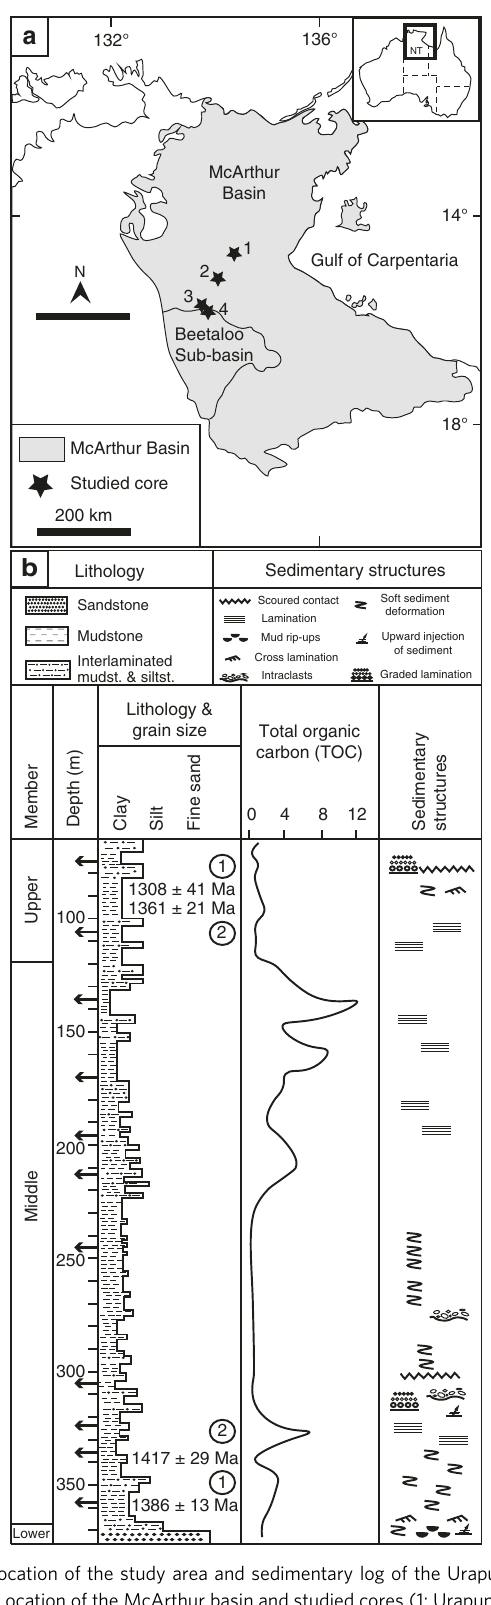
Fig. 1 Location of the study area and sedimentary log of the Urapunga-1 core. a Location of the McArthur basin and studied cores (1: Urapunga-4, 2: Lady Penhryn-2, 3: McManus-1, 4: Walton-2). b log of the Urupunga-4 core for the interval housing the Velkerri Formation used as a type section in the absence of surface outcrop. Arrows indicate samples used (modi fi ed from 61 ; depositional age of the Velkerri Formation after Yang et al. 57 for 1 and Kendall et al. 40 for